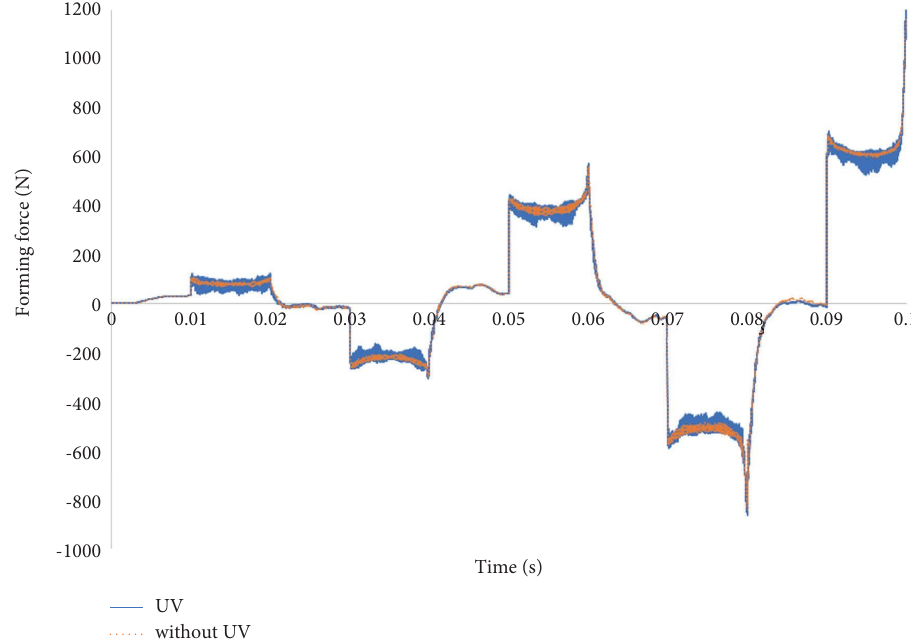
Figure 8: Planar force of straight groove simulation.